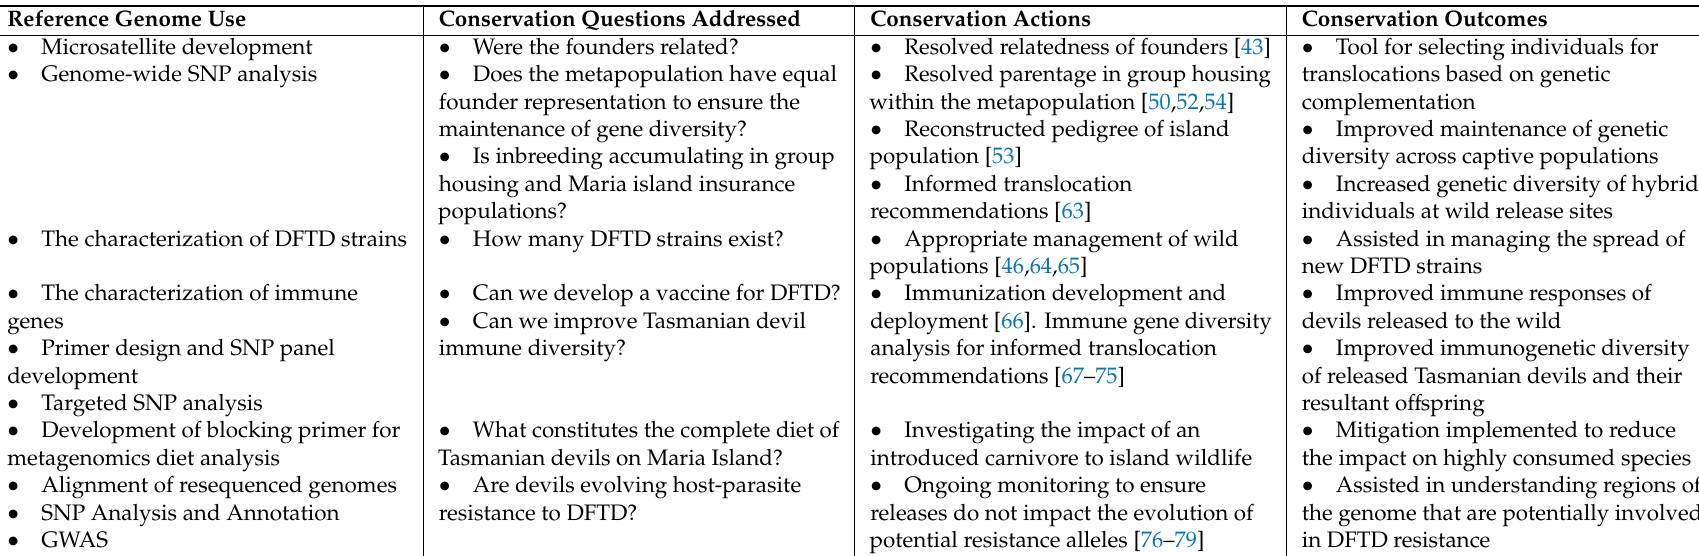
Table 1. Examples of Tasmanian devil conservation questions, actions, and outcomes that have been facilitated by the reference